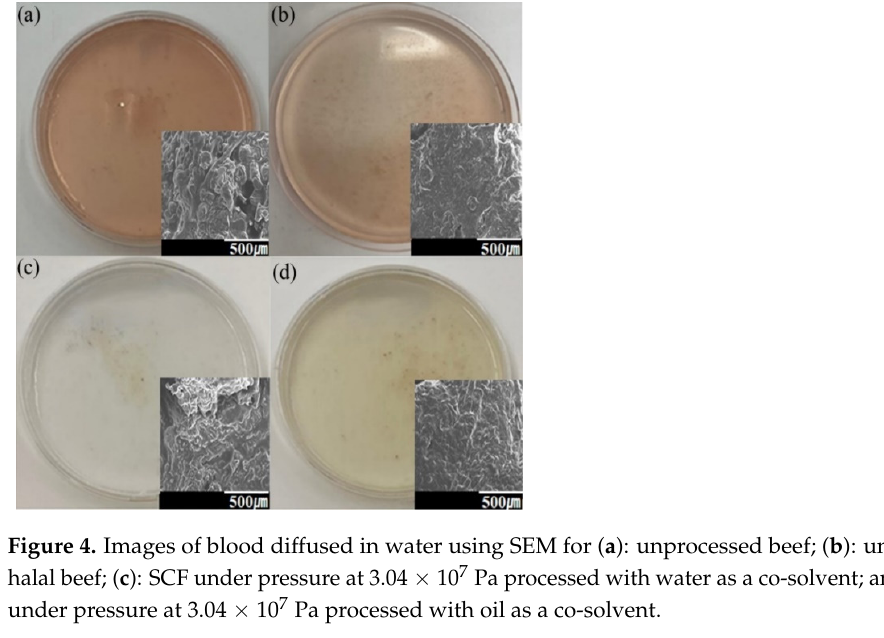
Table 3. Discharge data for air and water volume and pressure intensification experiment results, according to tip size and press-speed (velocity of the